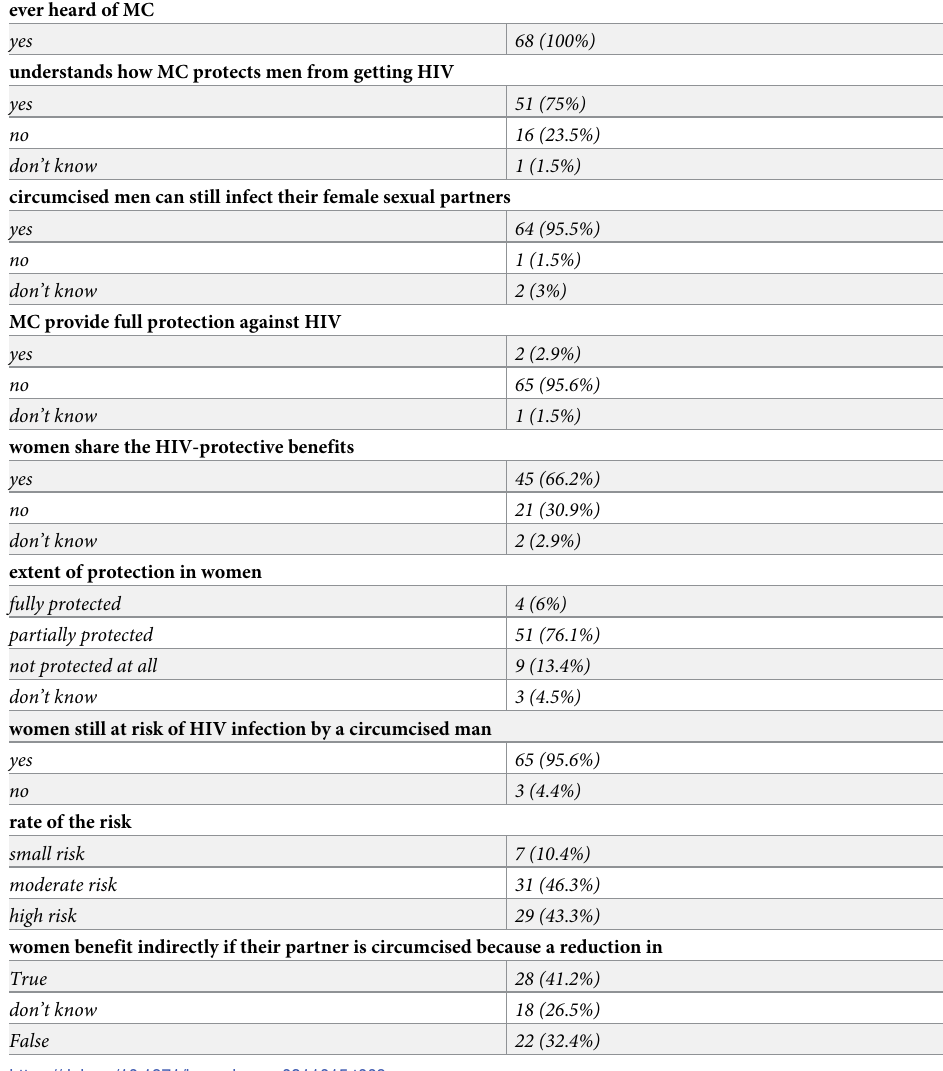
Table 3. Summary descriptive analysis of women understanding of